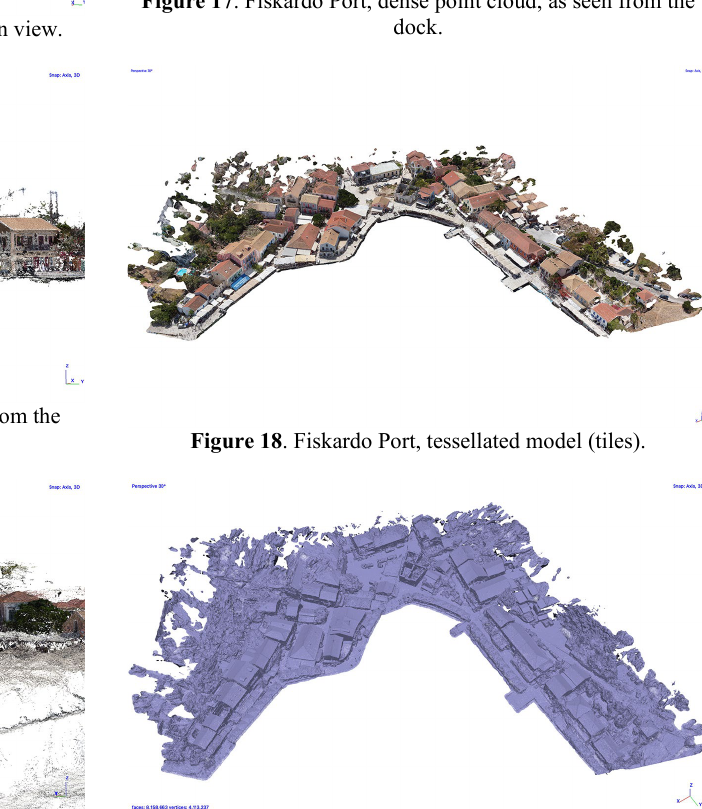
Figure 19 . Fiskardo Port, 3D solid